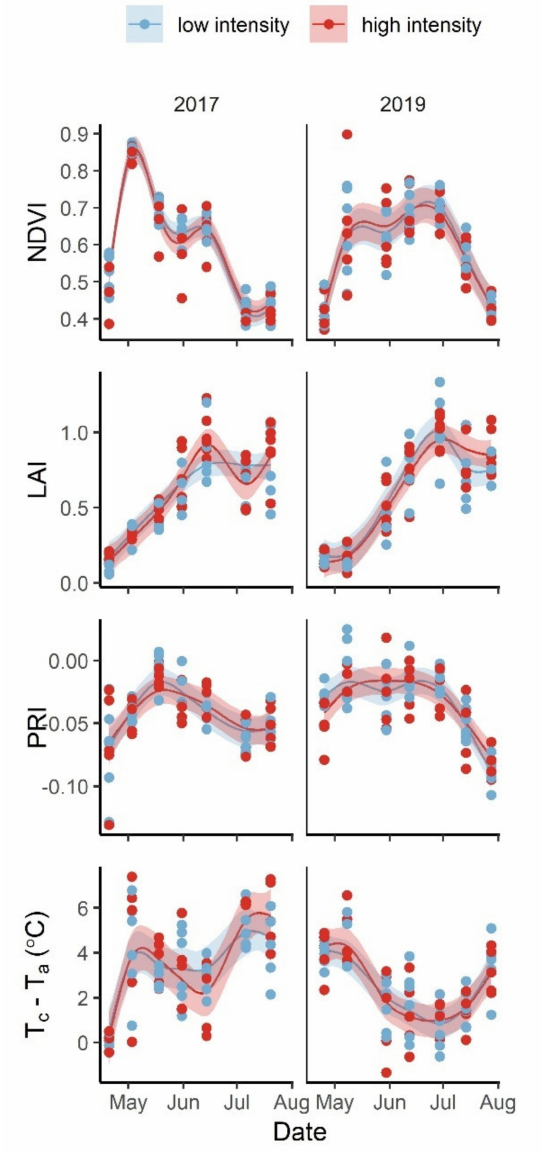
Figure 4. Normalized difference vegetation index (NDVI), leaf area index (LAI), photochemical reflectance index (PRI), and the difference between canopy and air temperature (T c − T a ) in low- versus high-precipitation-intensity plots. Data from 2017 (left panels) and 2019 (right panels) are shown. The lines show the predicted values from the generalized additive mixed models (GAMMs), and the shaded regions are 95% confidence intervals. Treatments were grouped into two precipitation intensity categories: low intensity (1 mm, control, 2 mm, and 3 mm treatments) and high intensity (4 mm, 8 mm, and 18 mm treatments). While the null models outperformed the GAMMs presented here (indicating no significant treatment responses; Table S4), they are shown to illustrate our